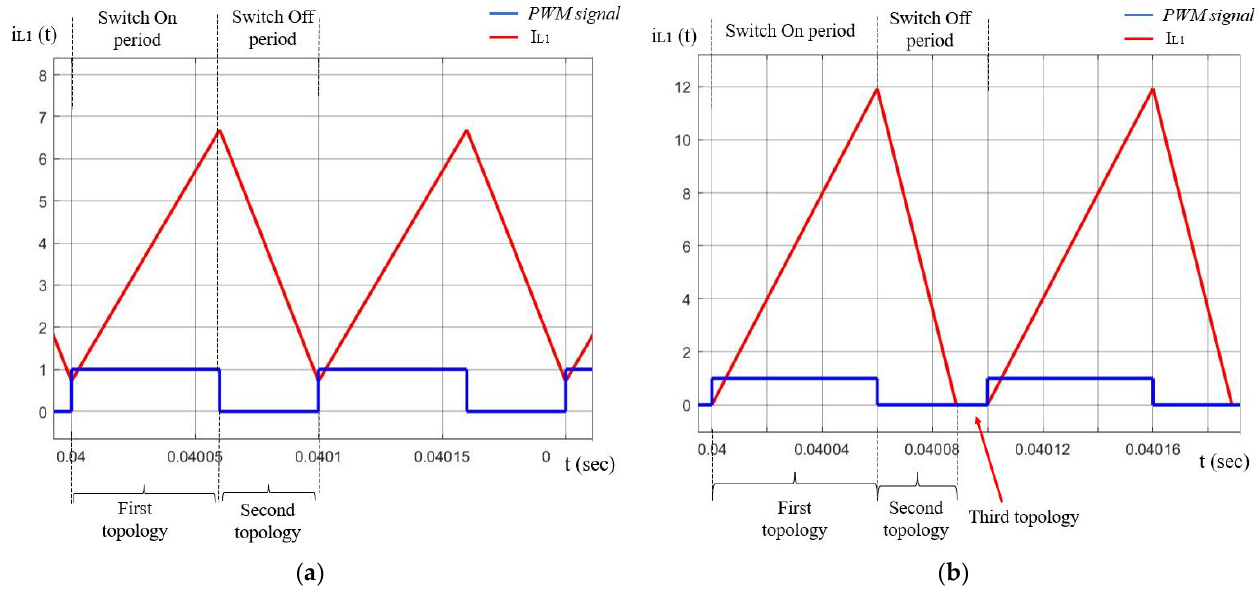
Figure 13. Testability assessment for a buck – boost converter: ( a ) definition of the two possible topologies in CCM; ( b ) definition of the three possible topologies in DCM.